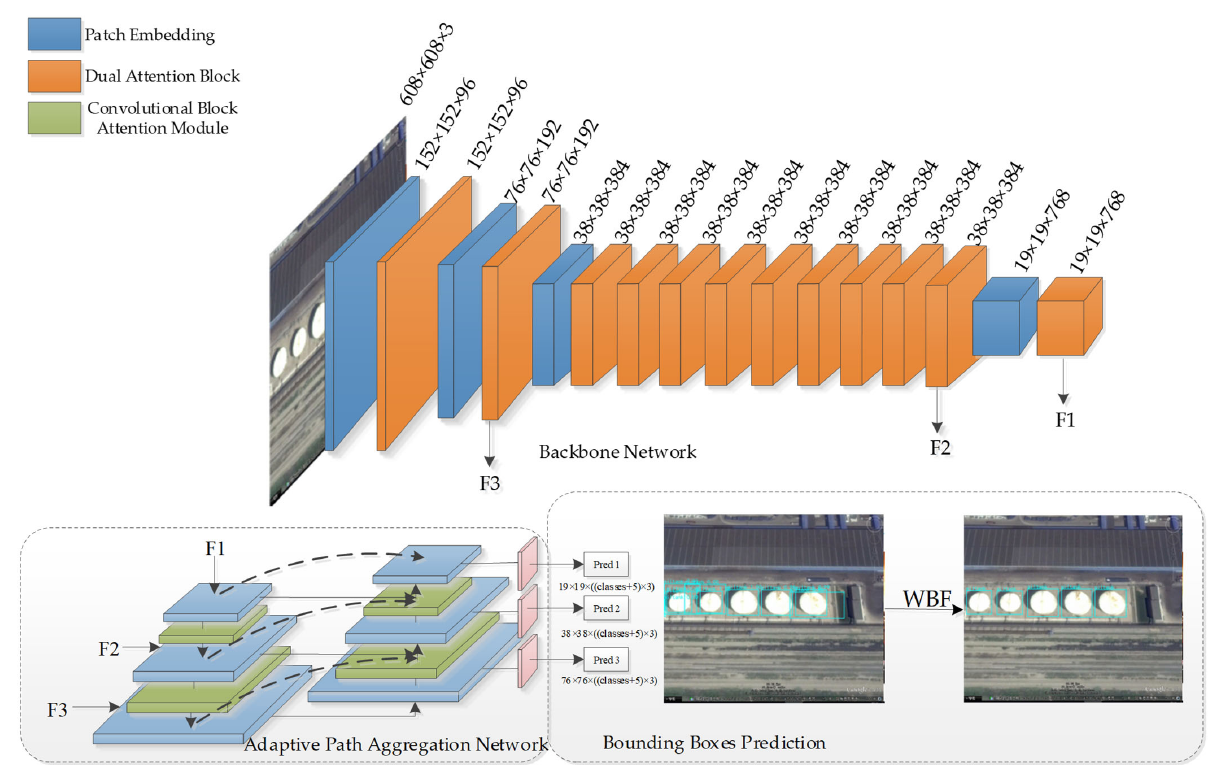
Figure 1. The whole structure of our